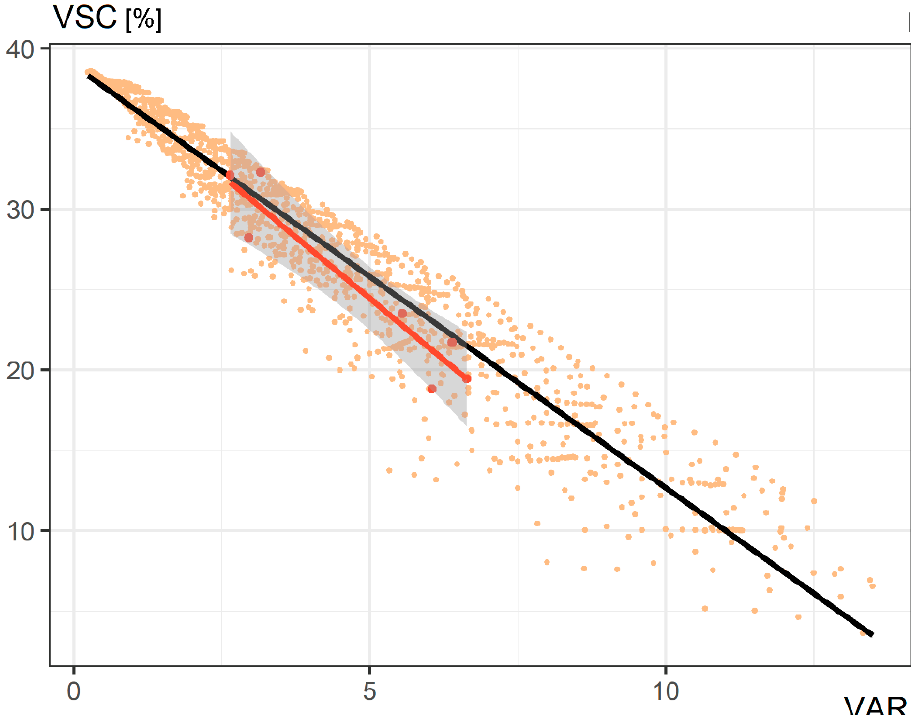
Figure 14. Linear regression function of metrics VAR and VSC based on neighbourhood iterations (black line) and case studies (red line), including the 95% CI for the case studies regression line indicated by the grey area.